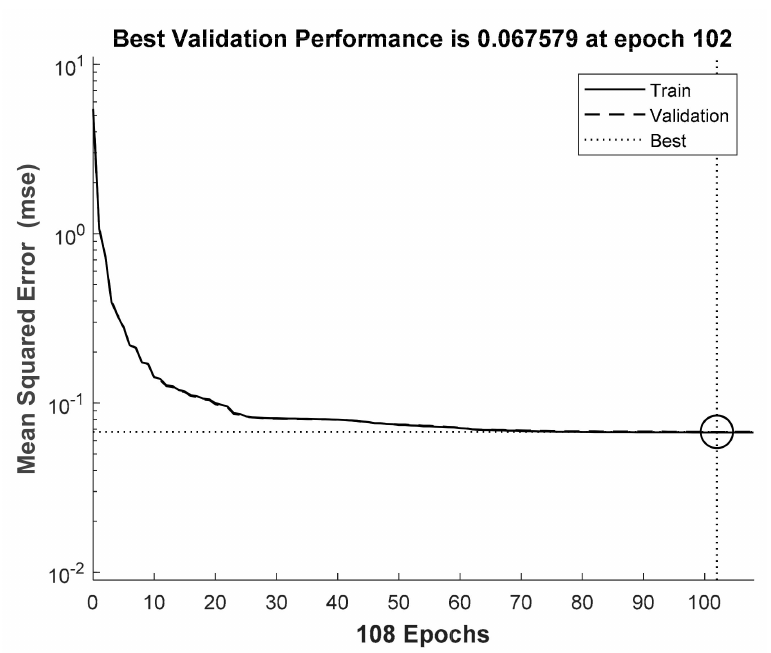
Figure 7. Learning curve of the network with two hidden